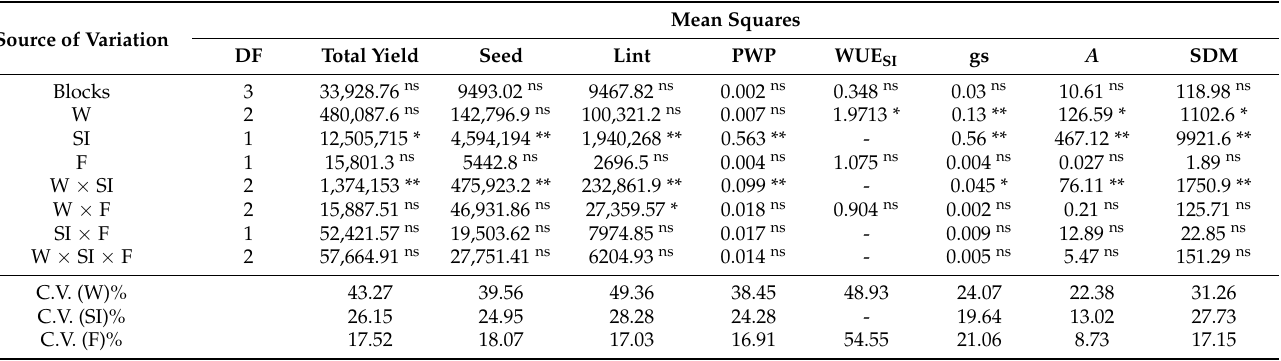
Table 3. Summary of analysis of variance for cotton yields (total, seed, and lint), expressed in kg ha − 1 , physical water yield (PWP , kg m − 3 ), the efficiency of supplemental irrigation (WUE SI, kg m − 3 ), stomatal conductance (gs, mol m − 2 s − 1 ), photosynthetic rate ( A, µ mol m − 2 s − 1 ), and shoots’ dry mass (SDM, g) as a function of water scenarios (W), supplemental irrigation (SI) with treated wastewater, and chemical fertilization (F).